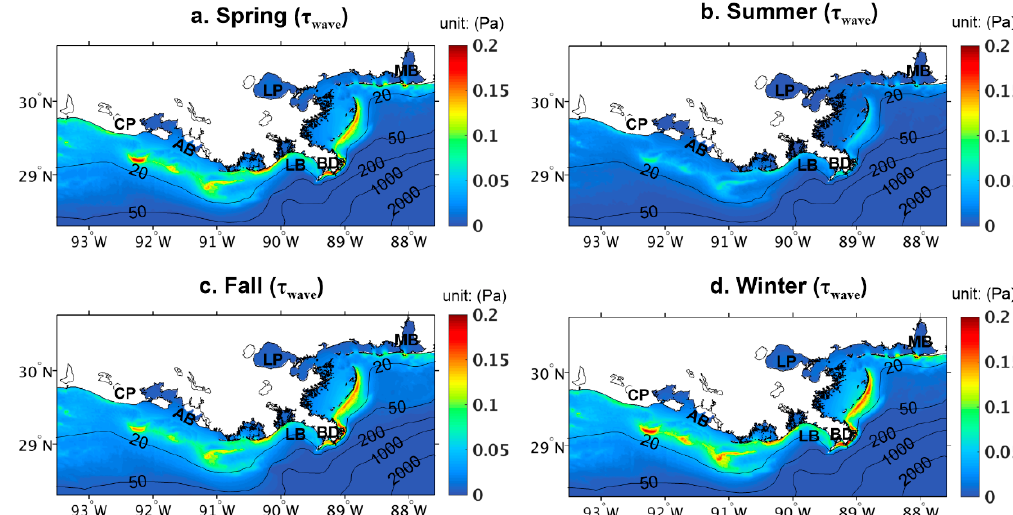
Figure 11. Wave-induced bottom shear stress ( τ wave ; color) in spring ( a ), summer ( b ), fall ( c ), and winter ( d ). (AB: Atchafalaya Bay; BD: Bird-Foot Delta; LP: Lake Pontchartrain; MB: Mobile Bay; LB: Louisiana Bight; CP: Chenier Plain).